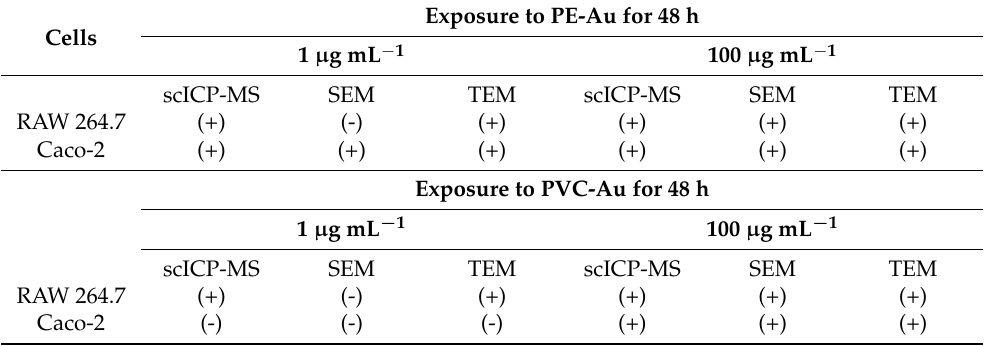
Table 1. A summary of the results obtained by three different detection techniques after the exposure of RAW 264.7 or Caco-2 cells to PE-Au or PVC-Au nanoplastics for 48 h, at concentrations of 1 or 100 µ g mL − 1 ; (+) indicates the detection of the materials and (-) indicates that no materials are